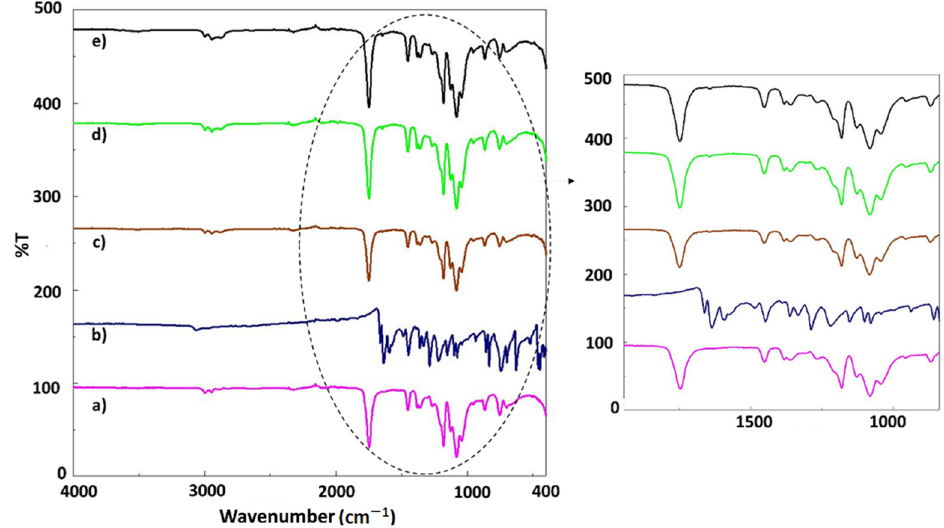
Figure 2. FT-IR spectra of the PLA ( w / v ) ( a ), pristine juglone ( b ), and scaffolds: PLA ( w / v )/10 J ( c ), PLA ( w / v )/20 J ( d ), an PLA ( w / v )/30 J ( e ).